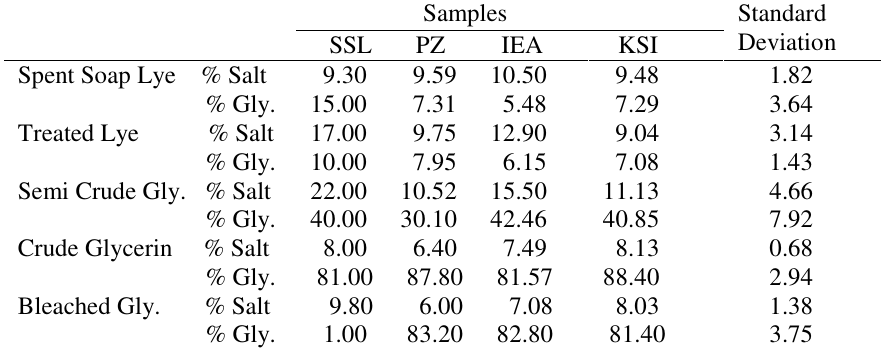
Table 4. Standard deviation for % salt and % glycerin for samples at different stages stages of